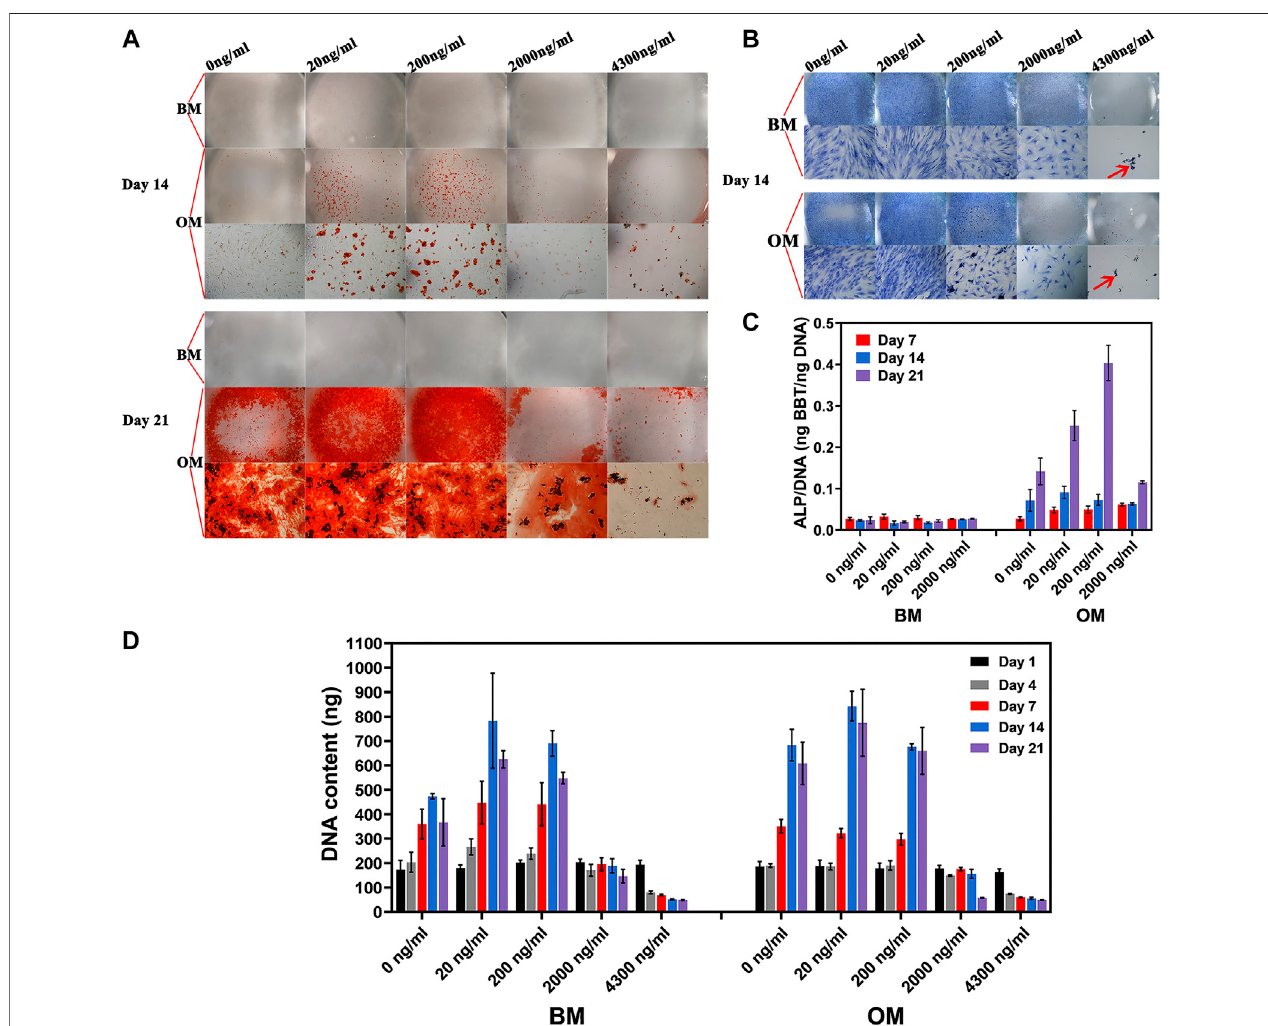
FIGURE 4 | hBMSC proliferation and osteogenic differentiation in different culture medium. (A) Mineralization and (B) cell morphology of hBMSC in basic medium and osteogenic medium asthe function of icaritin dose (red arrow stands for un-dissolved icaritin crystals), (D) hBMSC proliferation, and (C) osteogenic differentiation in BM and OM as a function of icaritin